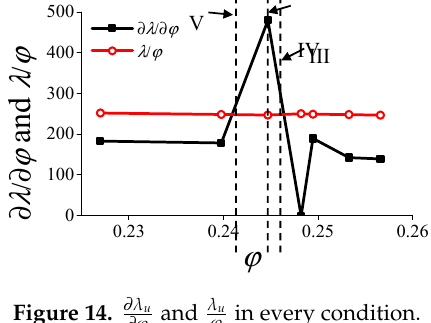
Figure 14. Figure 14. u Figure 14. u